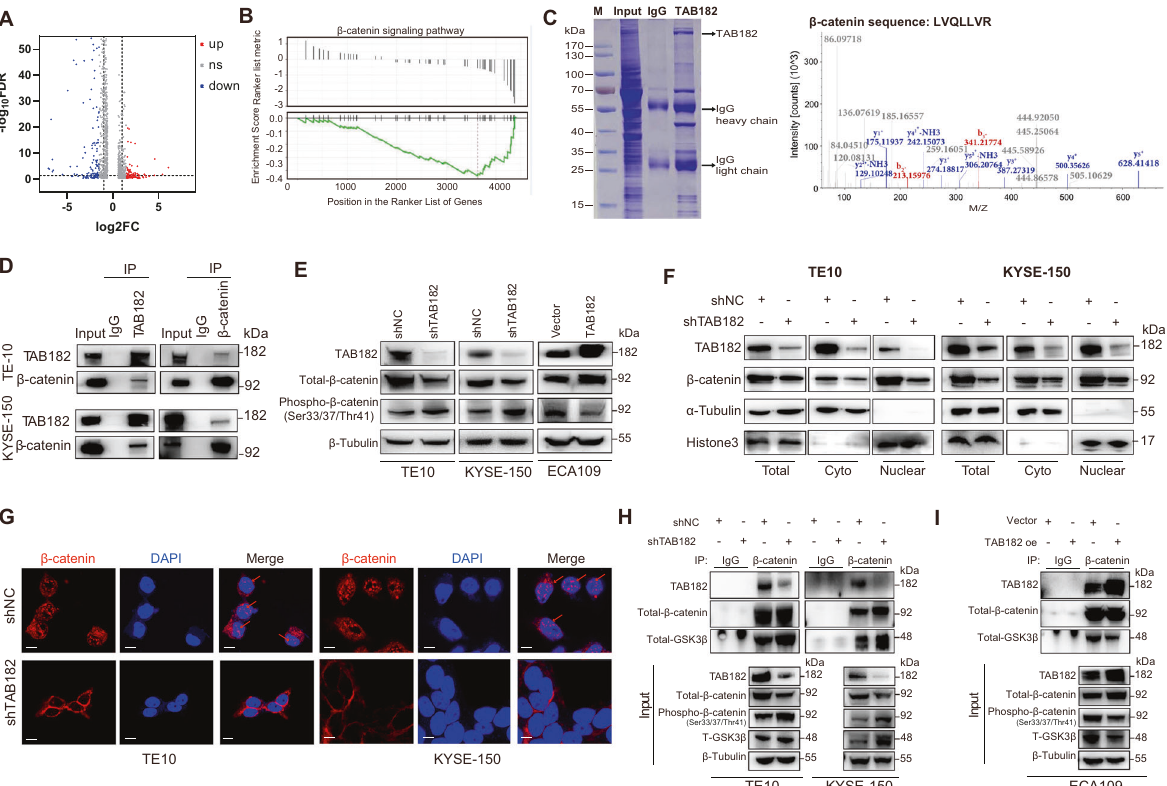
Fig. 3 TAB182 regulates the β -catenin signaling pathway via affecting the nuclear translocation of β -catenin. A volcano plot showing differential expressed genes between shNC and shTAB182 TE-10 cells. B RNA transcriptome data was reanalyzed using Gene Set Enrichment Analysis. NES = − 1.52, P < 0.05. C Coomassie Blue-stained SDS-PAGE gel of co-immunoprecipitation products of TAB182. The MS/MS spectra show the presence of peptide peaks corresponding to the β -catenin sequence (LVQLLVR). D co-immunoprecipitation was performed by using TAB182 and β -catenin antibody, and the IP product was analyzed by immunoblotting. E western blotting analysis of the indicated total β -catenin and phosphorylated β -catenin proteins. F western blotting analysis of nuclear expression of β -catenin in TAB182 knockdown and overexpressed cells. G immuno fl uorescence staining of nucleus location of β -catenin in TE-10-shNC and TE-10-shTAB182 cells, KYSE-150-shNC and KYSE-150-shTAB182 cells. H, I immunoprecipitation detection of interaction between β -catenin and GSK3 β in TAB182 decreased and overexpressed ESCC